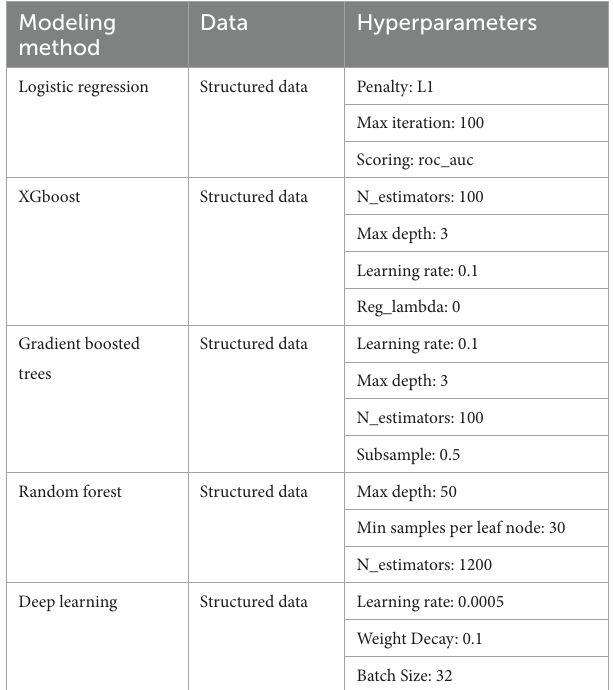
TABLE 1 Hyperparameters for the tuned